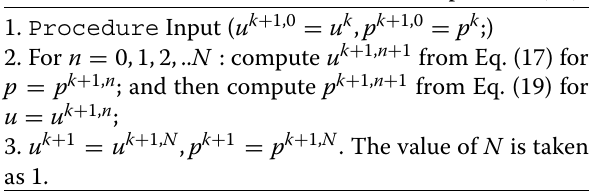
Algorithm 2 :Algorithm for Augmented Lagrangian method for the ROF model-solution of sub-problem